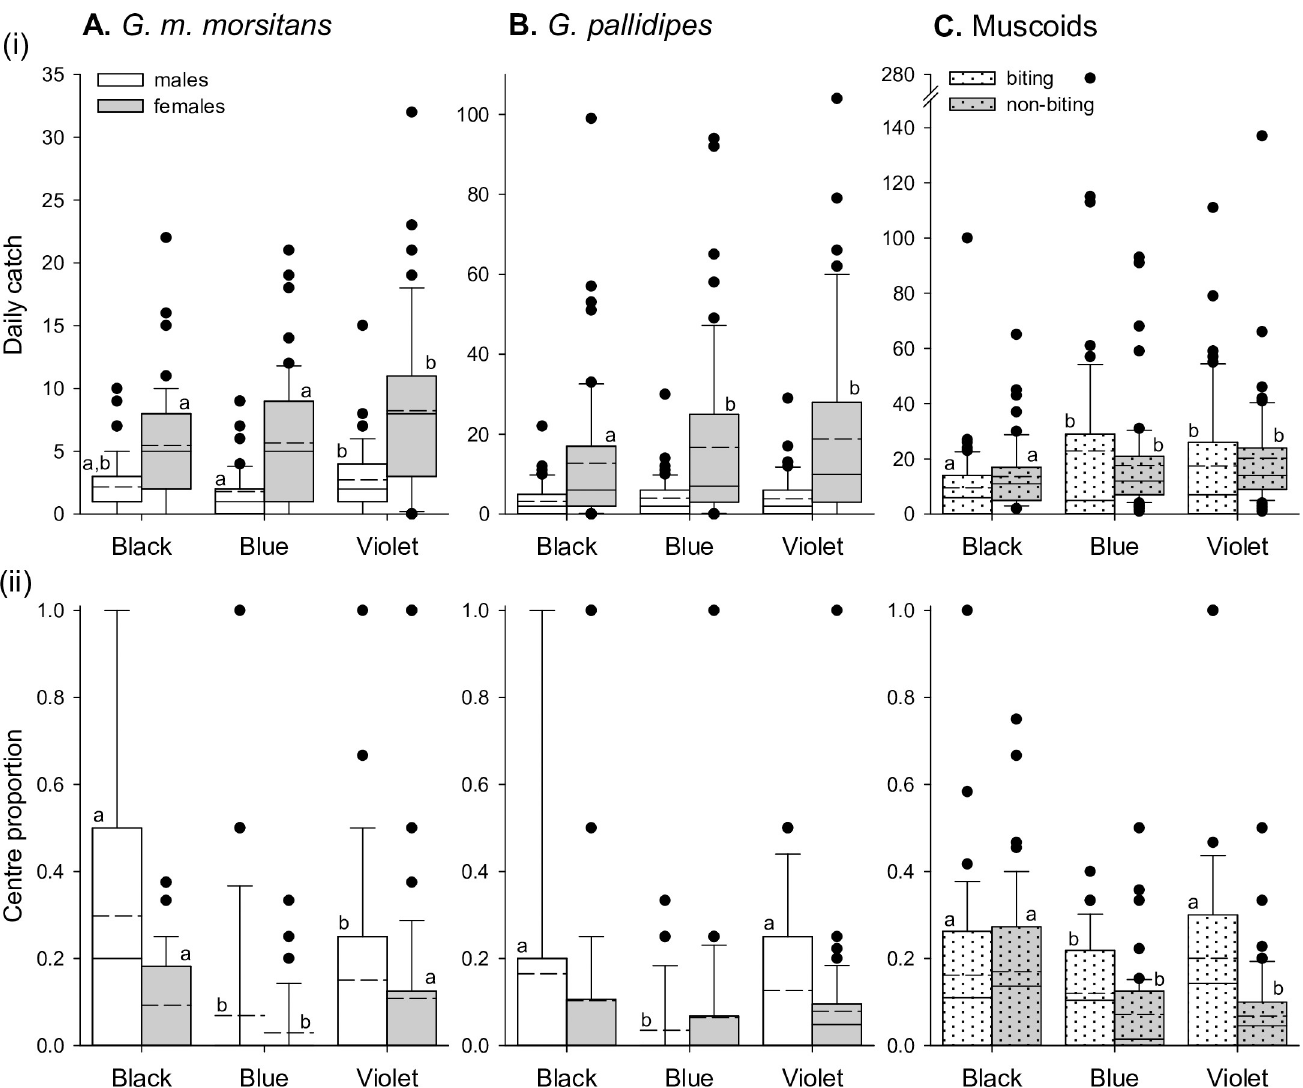
Fig 4. Catches of biting flies at new polyester and traditional cotton targets with odour lures. Data are plotted for male and female G . m . morsitans (A), and G . pallidipes (B), and for biting and non-biting muscoid species (C). (i) Upper panels show daily catches recorded on each sampling day. (ii) Lower panels show the proportion of the catch that was intercepted at the centre panel on each sampling day. Target designs are described in Table 1, and data are from a total of 17 Latin squares encompassing 51 sampling days. Figure conventions are as described for Fig